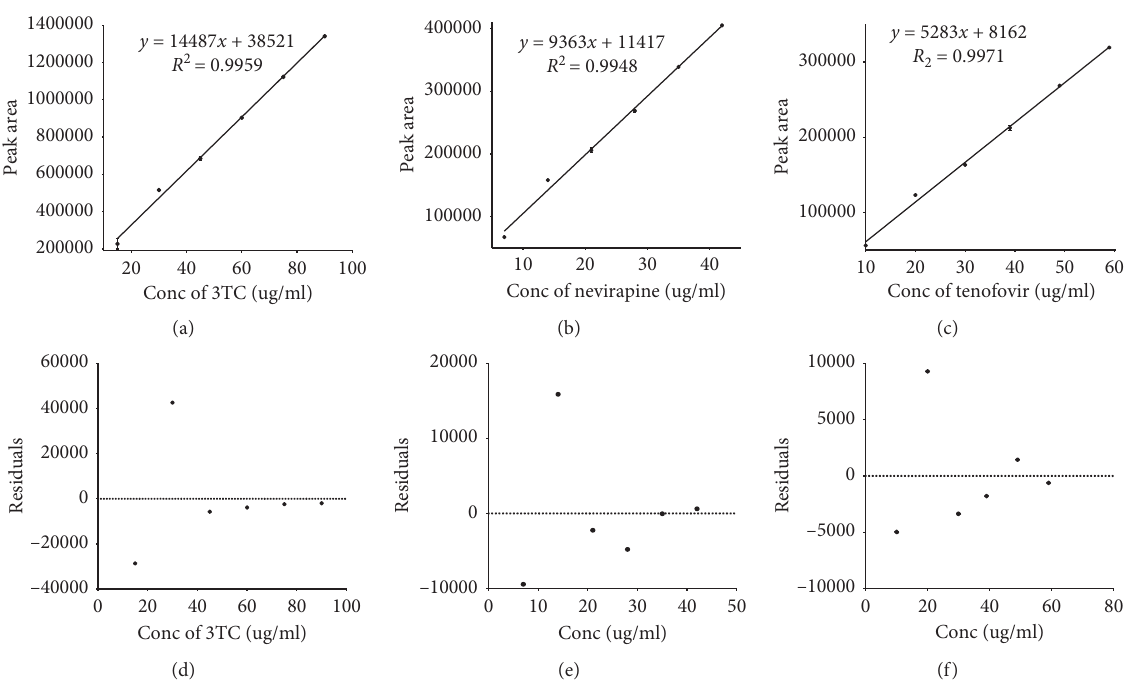
Figure 2: Proof of linearity of the developed method. (a) A